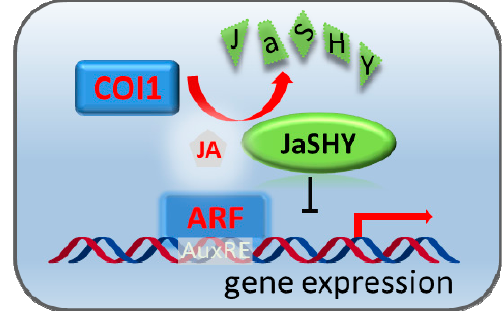
Figure 5. Schematic representation of jasmonate-induced, ARF7-mediated auxin responsive gene expression in protoplasts. In the absence of JA, the transcriptional activity of ARF7 is repressed by the chimeric protein JaSHY. In the presence of JA, JaSHY is degraded by COI1, leading to the liberation of ARF7 transcriptional activity.